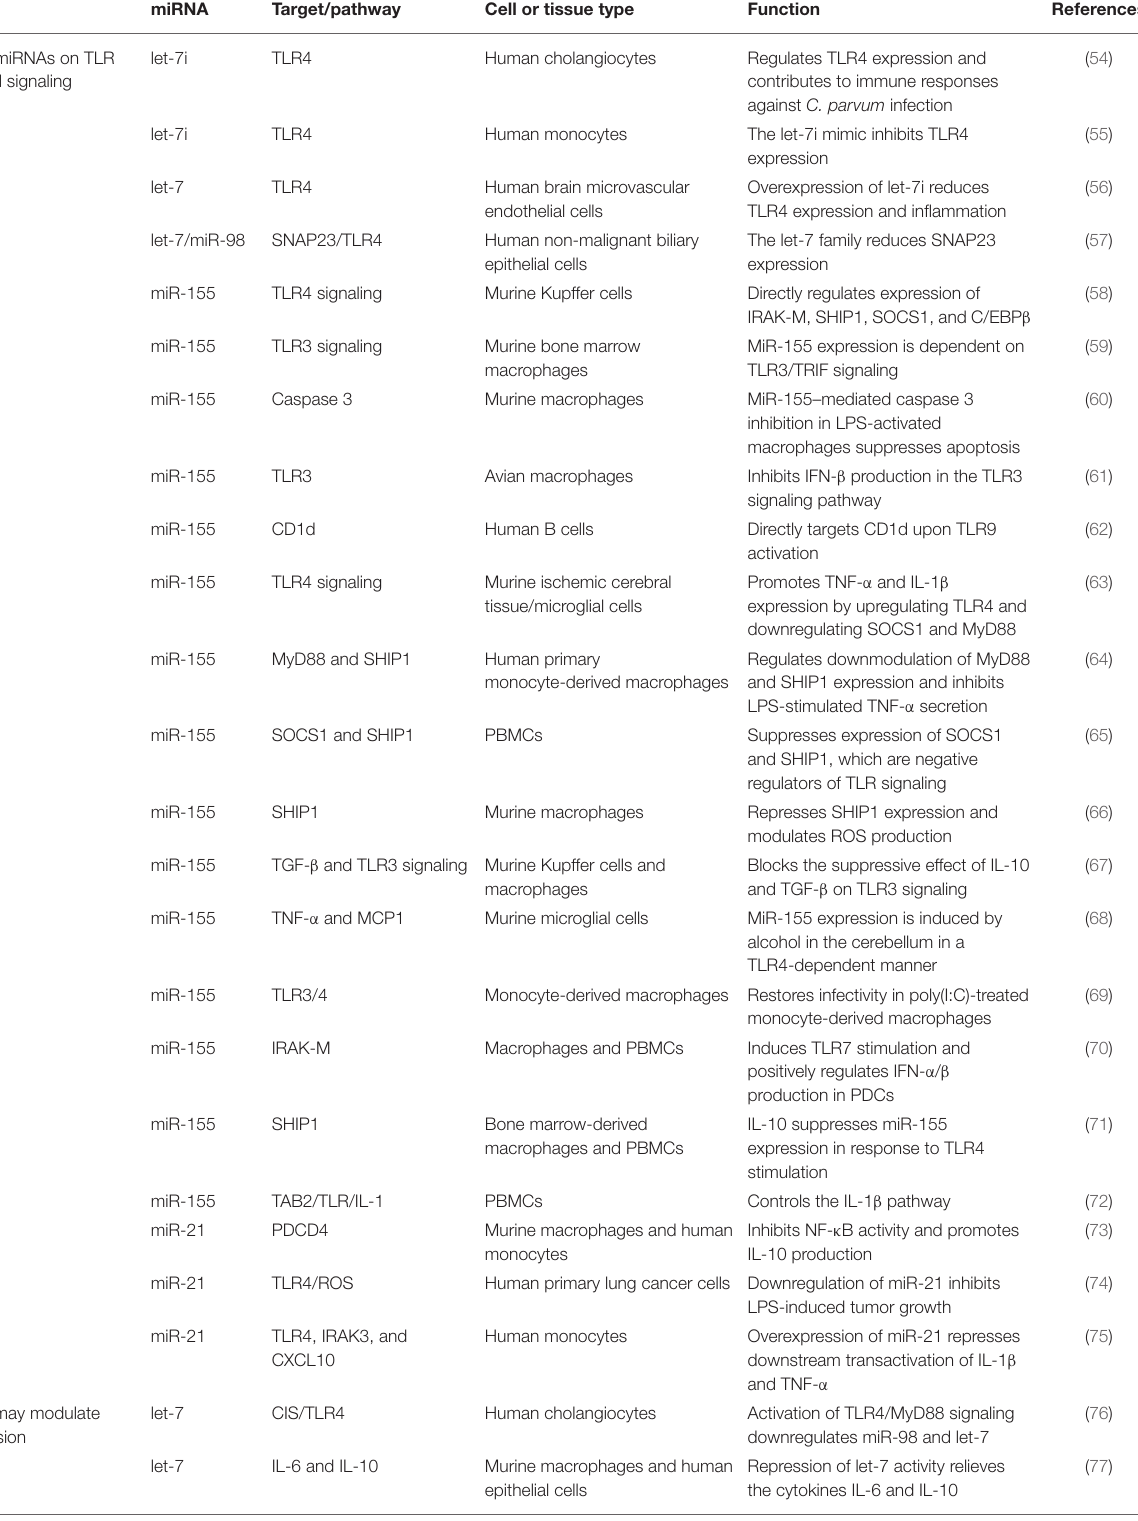
TABLE 1 | The regulatory effects of miRNAs on TLR signaling and the TLRs that regulate the miRNAs. miRNA Target/pathway Cell or tissue type